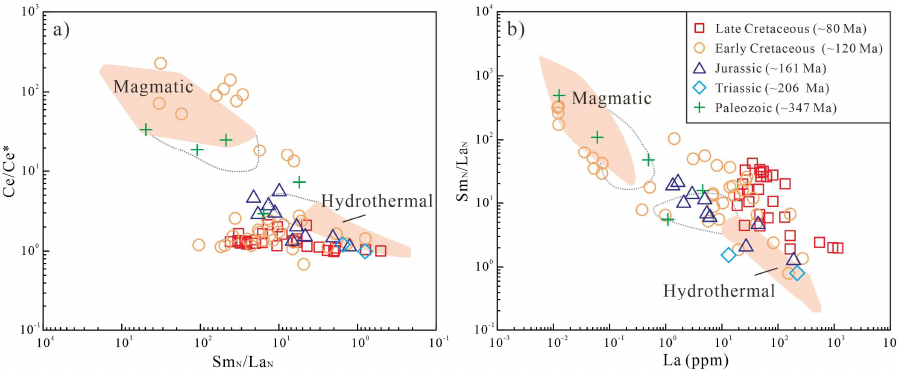
Figure 13. Zircon classification diagram. ( a ) Sm/La vs. Ce/Ce* [42] and ( b ) La vs. Sm/La [42].